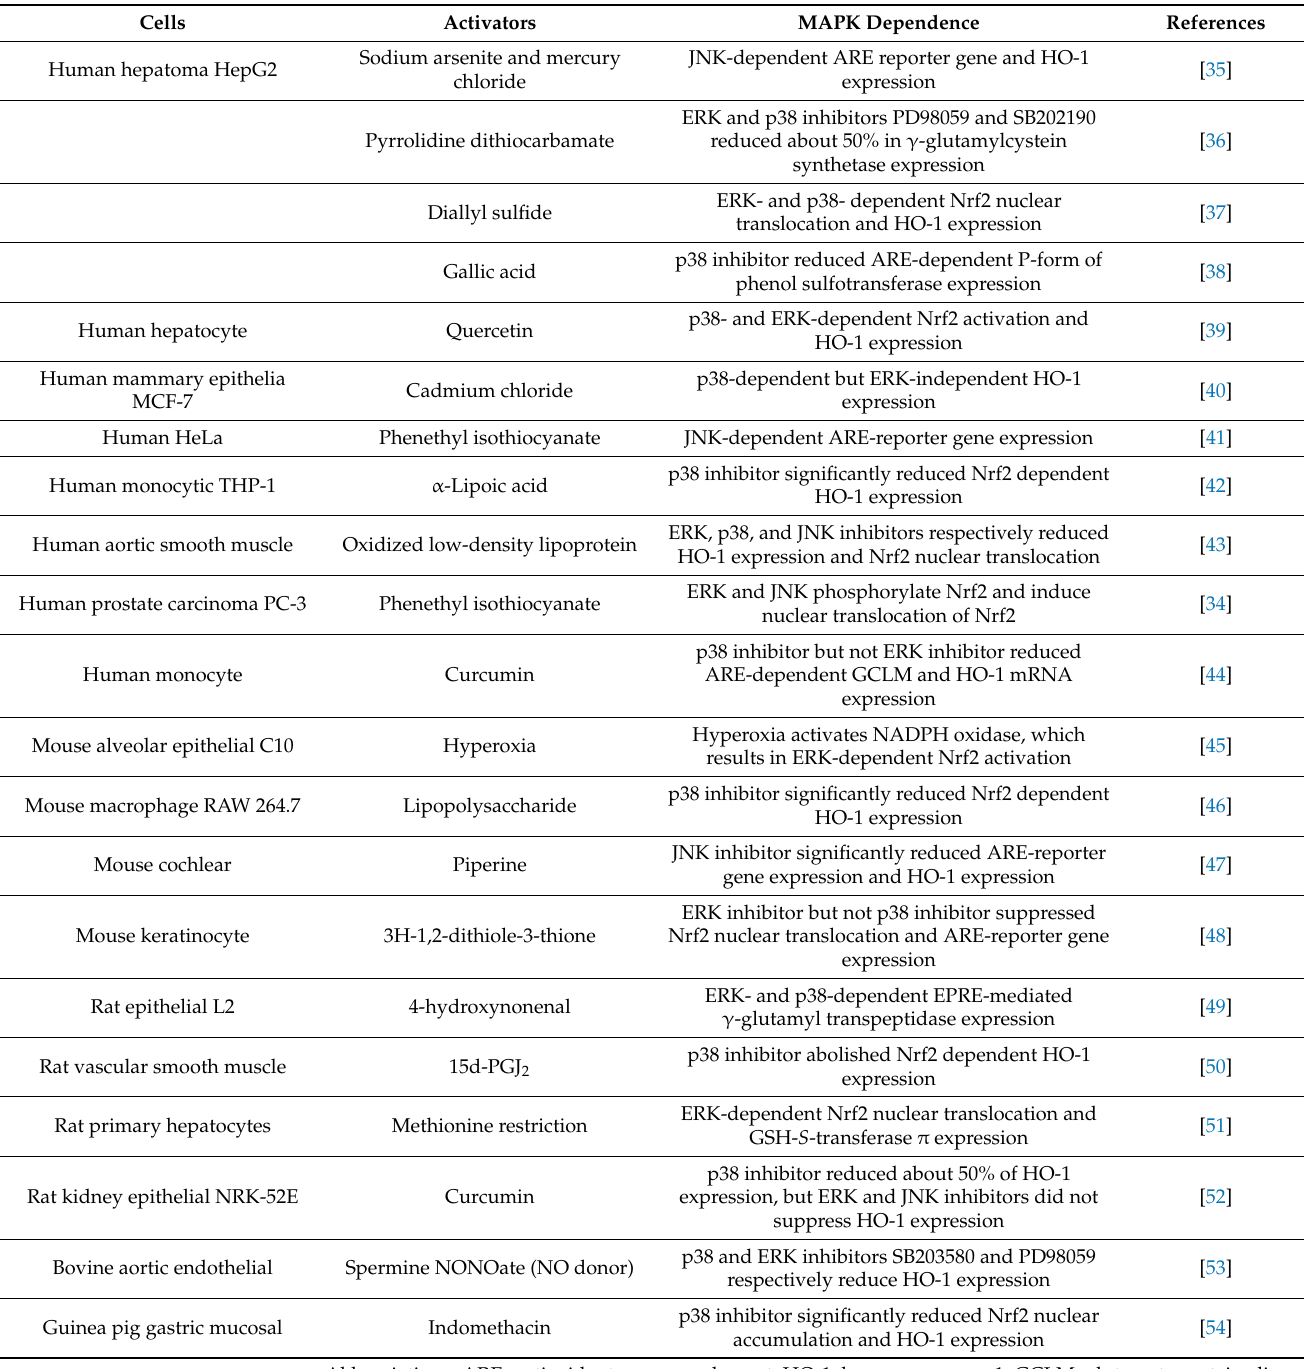
Table 1. MAP kinase-dependent Nrf2